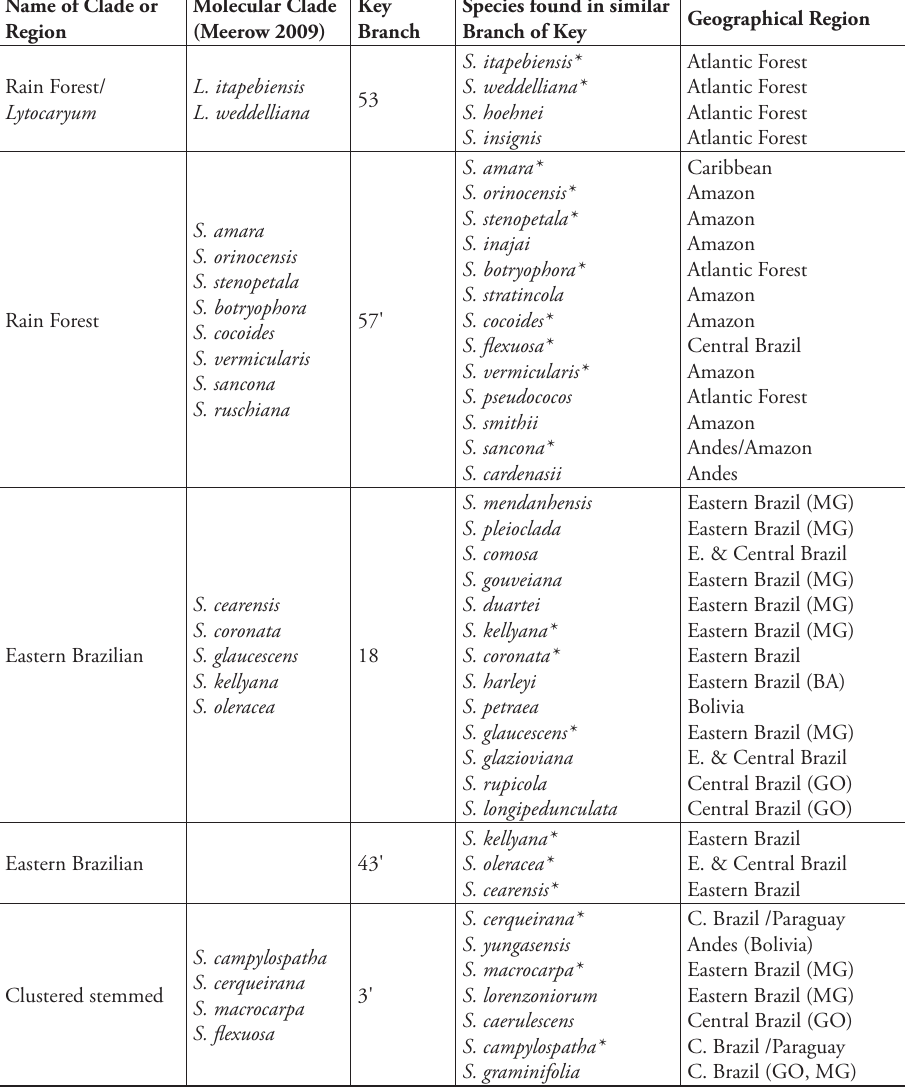
Key to Syagrus identification using leaflet margin anatomy... Table 1. Comparison of molecular clades and key branches. Meerow et al. (2009) designated three clades based on nuclear DNA sequences in Syagrus : Rain Forest, Eastern Brazilian, and Cluster stemmed. Taxa with an asterix (*) in column 4 were part of the original molecular analysis (Meerow et al. 2009). Name of Clade or Key Species found in similar Region Branch of Key